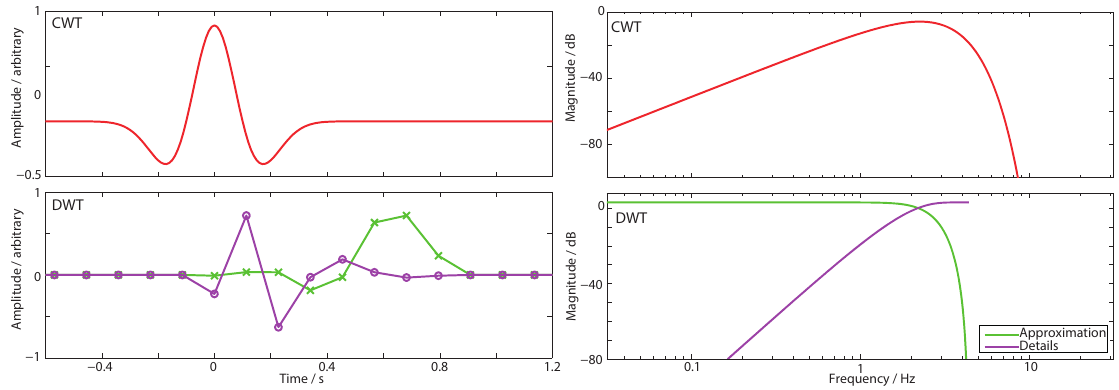
Figure 1. The Continuous Wavelet Transform ( top ), illustrated using the Mexican hat mother wavelet, is a signal processing basis which can be implemented very power efficiently in the analog domain by using fixed Q bandpass filters [5,14–19]; The Discrete Wavelet Transform ( bottom ), illustrated using the Daubechies 4 mother wavelet, is a related time–frequency decomposition transform which uses separate low pass (approximation) and high pass (details) filters; ( Left ) Mother wavelet time domain impulse response; ( Right ) Corresponding frequency response